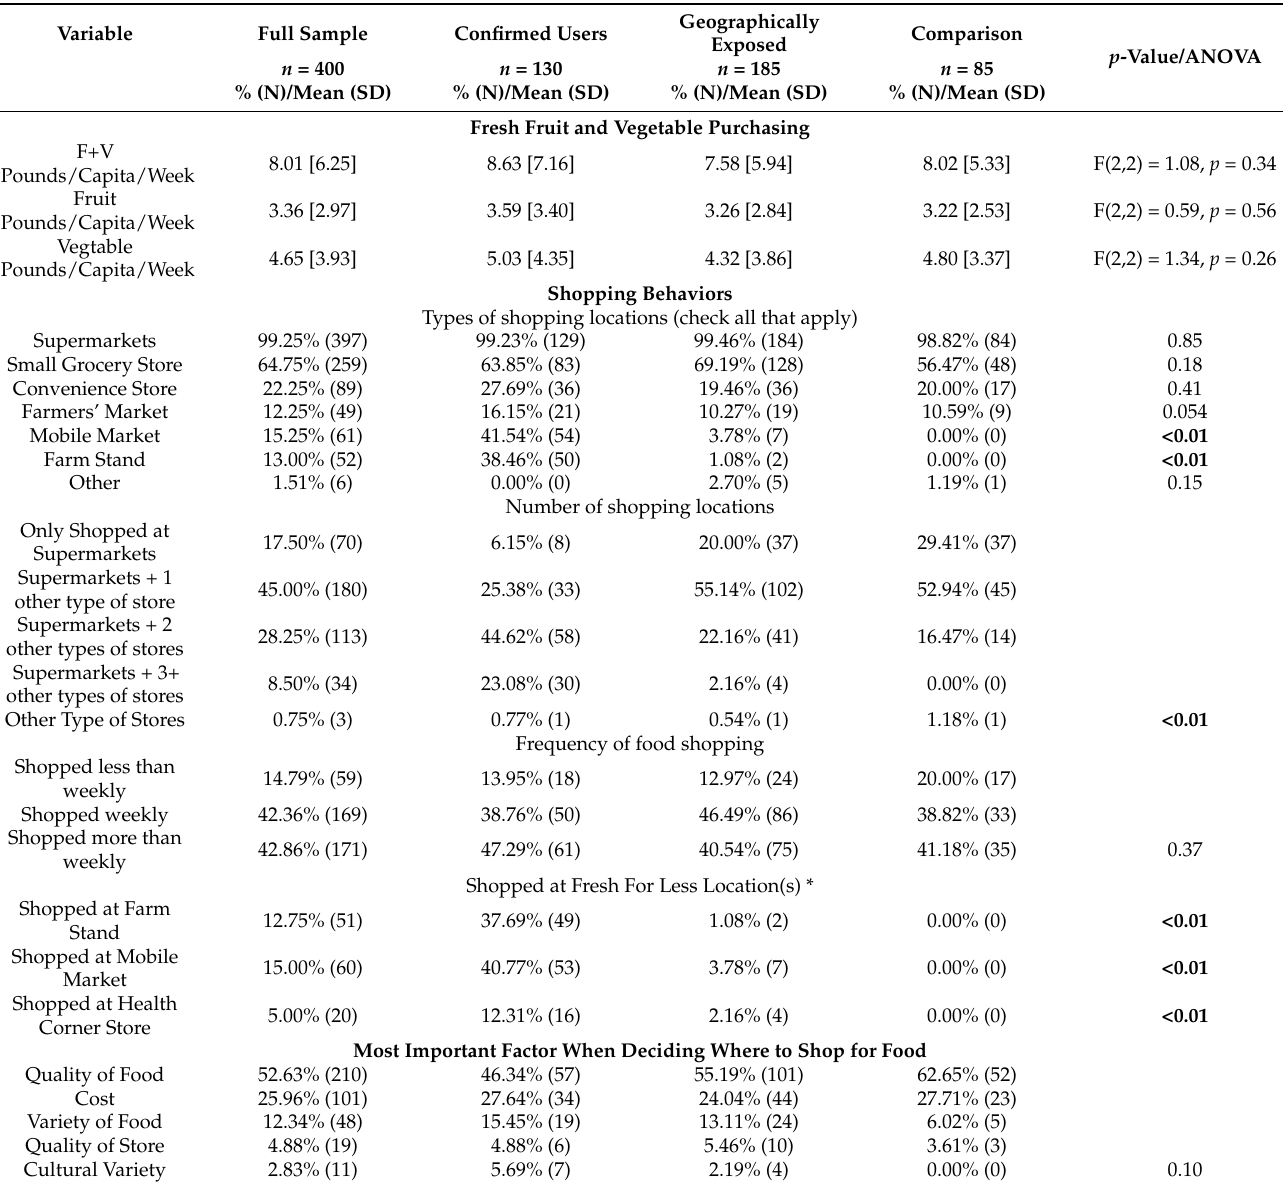
Table 3. Fruit and vegetable purchasing, food shopping behaviors and motivations among adults at baseline (FRESH Evaluation study Austin, Texas, (October 2018–March 2019).